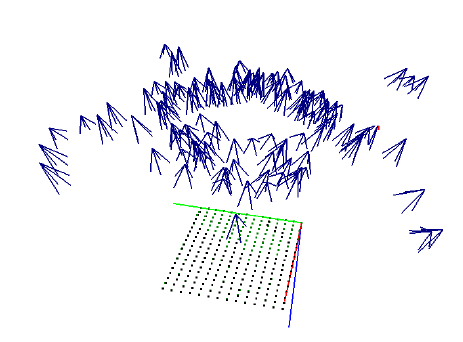
Figure 3. 3D plot of 36 poses used for the calibration and the chessboard corners (each pose is described by 3 cameras) to be an actual corner point of the chessboard in order to reduce the number of false positives to a minimum. Each corner point is defined relative to the tags with intervals of the corner points ( i x and i y ) and their number ( n x and y y ) in x and y direction ( i x and i y ). Given the print specific scale factors, mentioned in the previous section, the intervals of the corner points are assumed to be identical. After all corner points in all images taken for